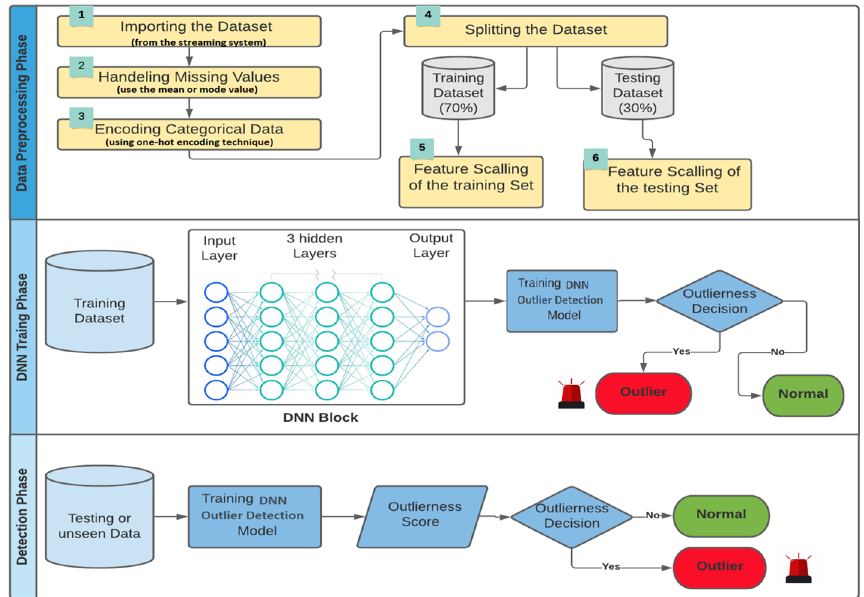
Fig. 3 The proposed DNN-based Outlier Detection